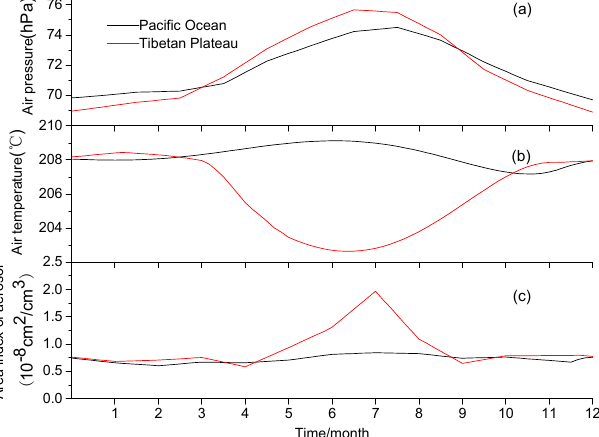
Figure 2. Changes in air pressure ( a ), temperature ( b ) and aerosol area index ( c ) with time at the altitude of 18 km in the lower stratosphere observed by SAGE II (black: the Pacific Ocean region (25–40 ◦ N, 140–180 ◦ E); red: the Tibetan Plateau (25–40 ◦ N, 70–110 ◦ E)).